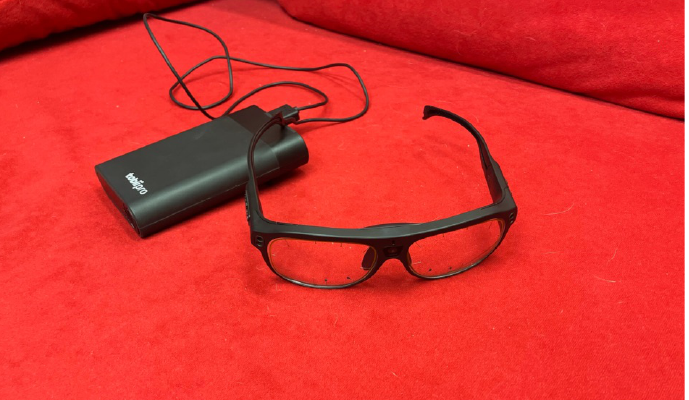
Figure 3. Tobii Pro Glasses 3.